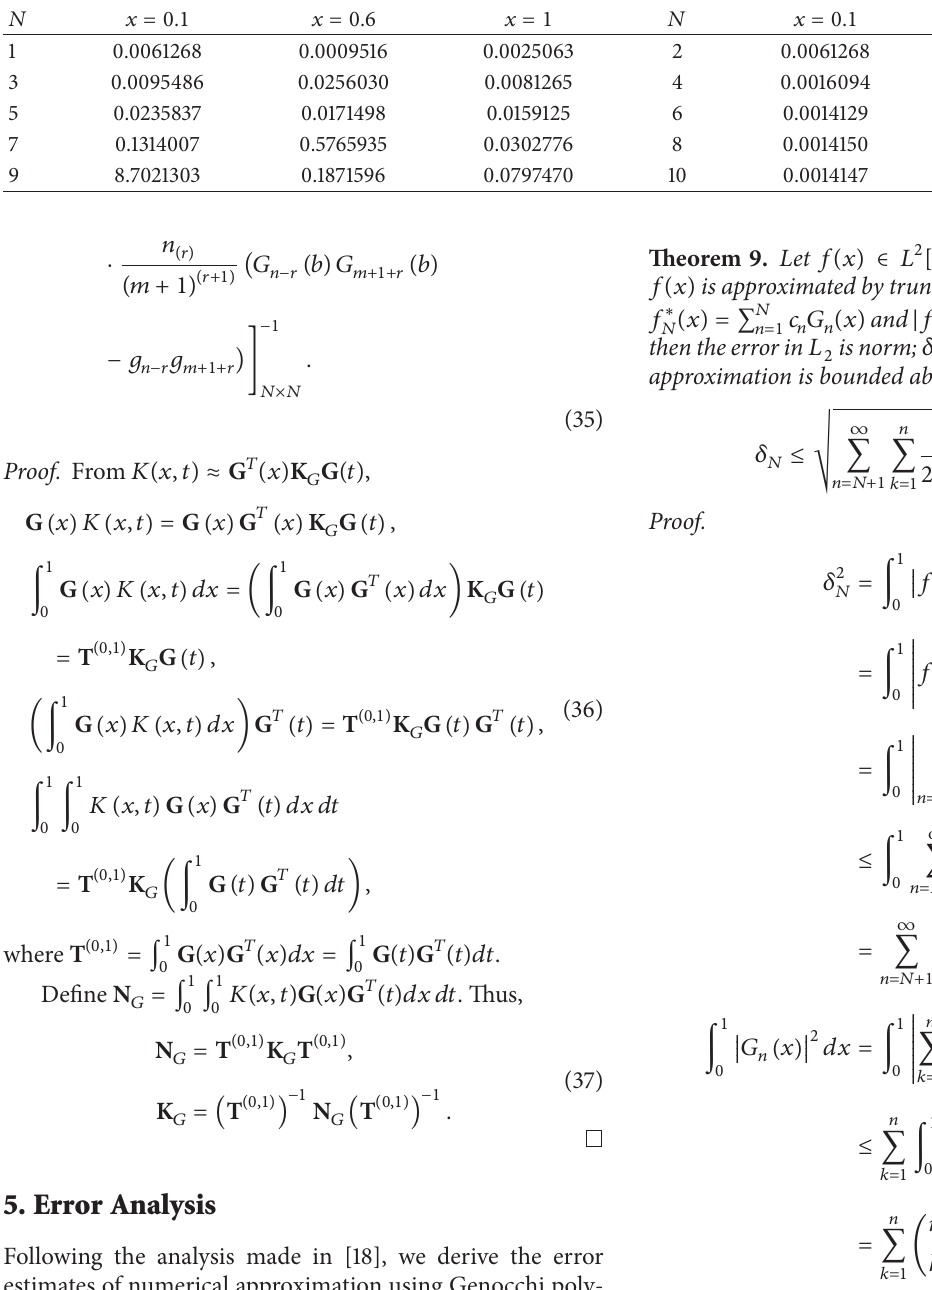
Table 2: Comparison of relative error between SLOMFD and GPOMFD with 𝛼 = 0.5 at points 𝑥 = 0.1, 0.6, 1 . SLOMFD GPOMFD